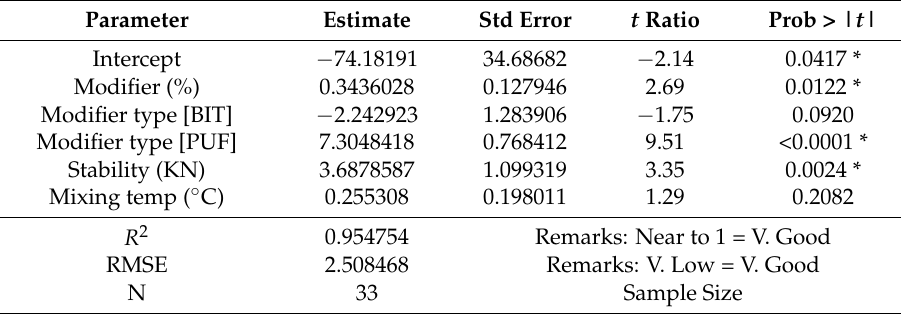
Table 7. Parameter estimates for the modeled